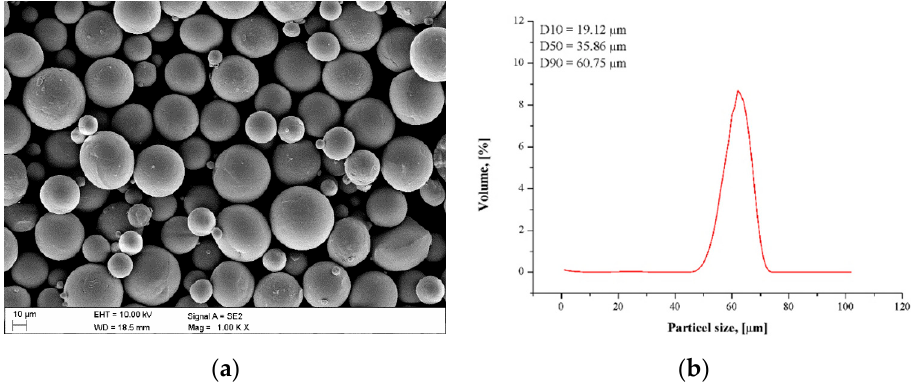
Figure 1. Ti6Al4V titanium alloy powder characterization ( a ) scanning electron microscope (SEM) image of powder morphology, ( b ) particle size distributions.